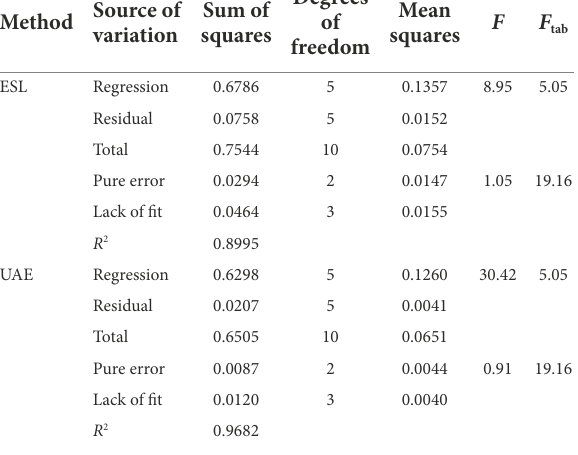
TABLE 1 Variance analysis (95% confidence level). Source of Method variation